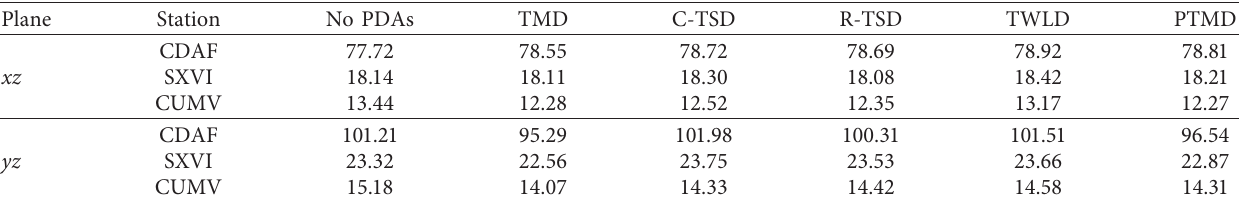
Figure 14: Seismic peak interstory drift ratios of the building: yz plane. (a) CDAF. (b) SXVI. (c) CUMV. Table 17: Peak seismic displacement [cm] at z � H